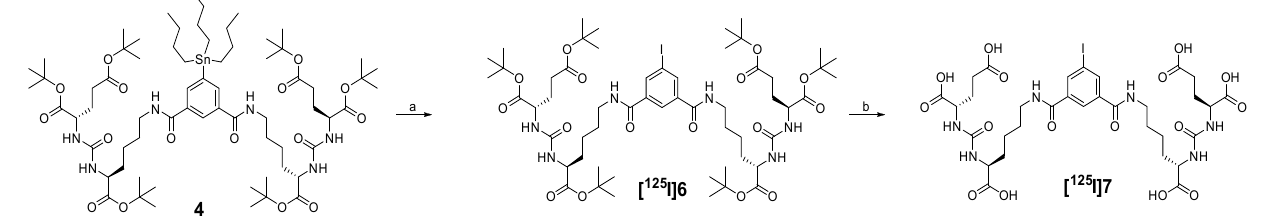
Figure 2. Radiolabeling synthesis route map of 125 I-PSMA-7. Reagents and conditions: ( a ) [ 125 I]NaI, HCl (1 M), H 2 O 2 (3%), r.t., 20 min; ( b ) CF 3 COOH, 50 °C, 10 min.